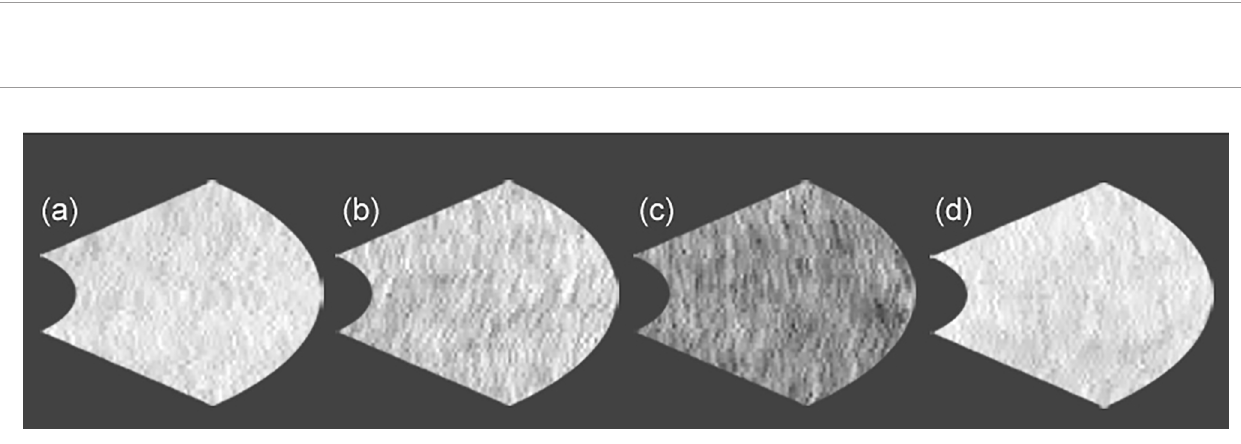
FIGURE 4 | The comparison of the re fl ectances at inner nasal grid of retinal pigment epithelium between control subject and patient with type 2 diabetes under glycemic control. (a) control subject at 6 months (223), (b) patient with type 2 diabetes at 3 months (204), (c) patient with type 2 diabetes at 6 months (147), and (d) patient with type 2 diabetes at 9 months (224). No. in the parenthesis reveals re fl ectance in arbitrary